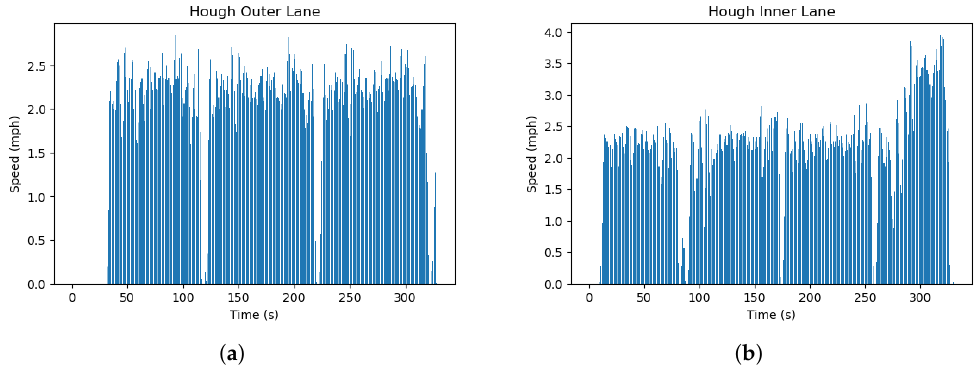
Figure A2. The graph of Hough algorithm for Outer and Inner